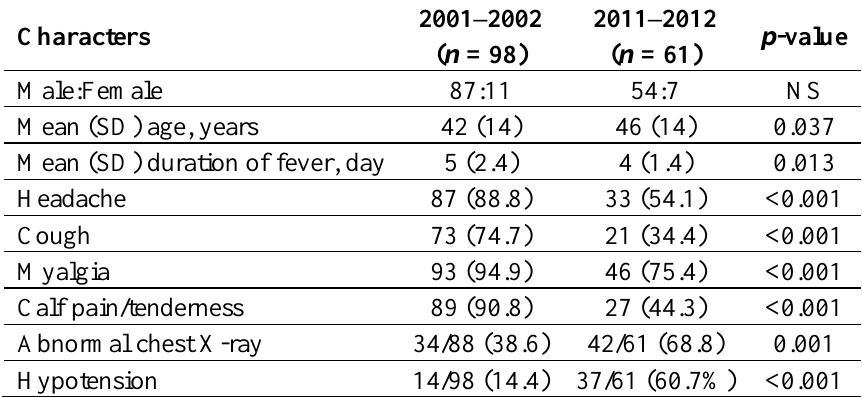
Table 2. Characteristics of patients with